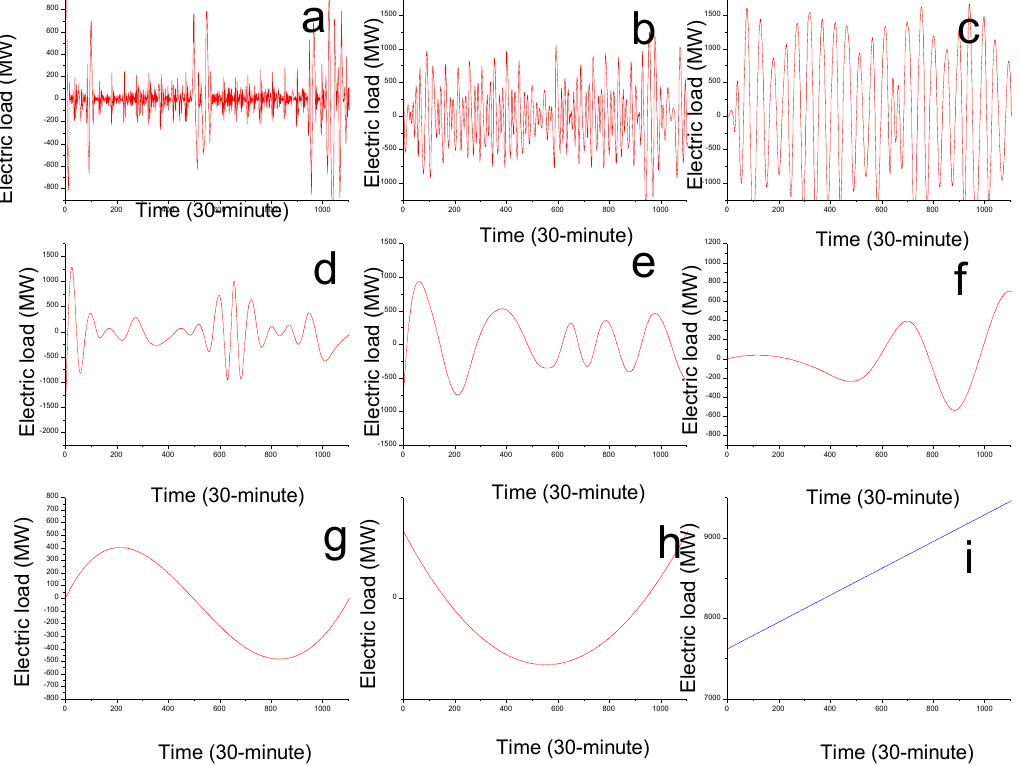
Figure 2. The decomposed items for the large sample data. ( a ) IMF1 (the random term); ( b ) IMF2 (the middle term 1); ( c ) IMF3 (the middle term 2); ( d ) IMF4 (the middle term 3); ( e ) IMF5 (the middle term 4); ( f ) IMF6 (the middle term 5); ( g ) IMF7 (the middle term 6); ( h ) IMF8 (the middle term 7); and ( i ) IMF9 (the trend (residuals) term).